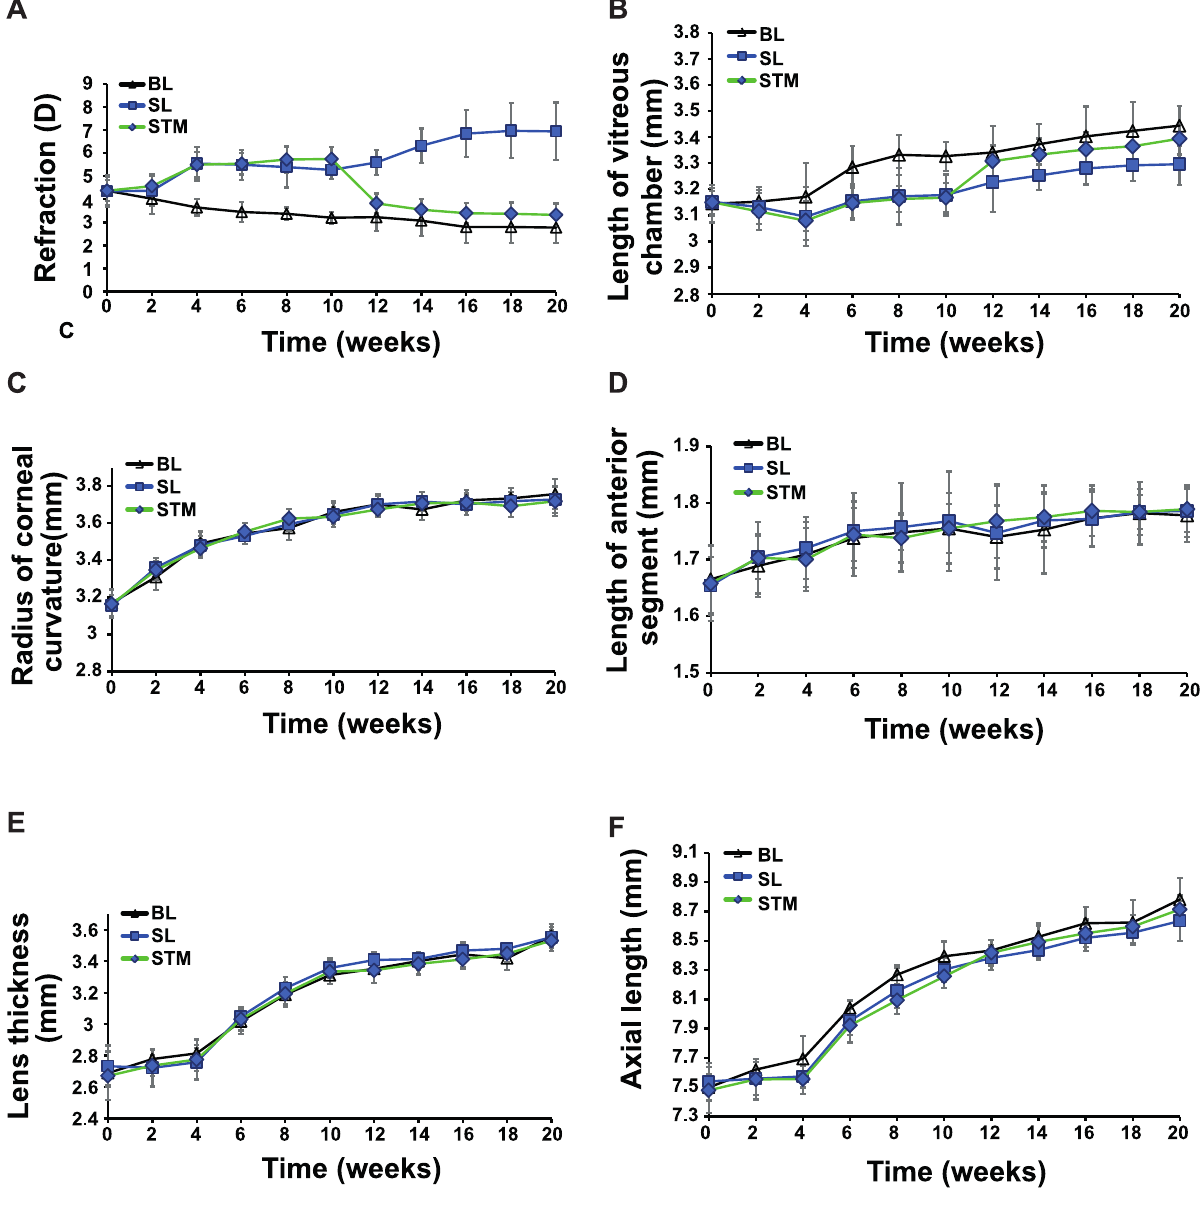
Figure 2. The comparisons in refraction and axial components between the STM and the control groups. (A) refraction; (B) vitreous length.; (C) corneal curvature; (D) length of anterior segment; (E) lens thickness; (F) axial length; short-wavelength to middle-wavelength group (STM); short-wavelength light group (SL); broad-band light group (BL).